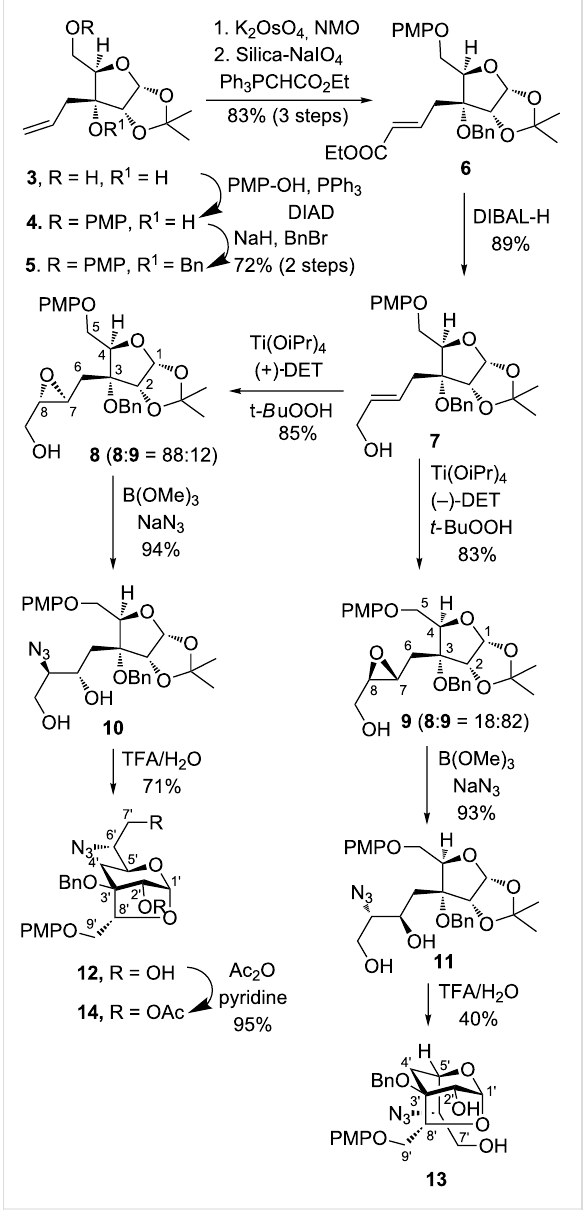
Scheme 2: Synthesis of 1,3-anhydrosugar 12 and 13 .